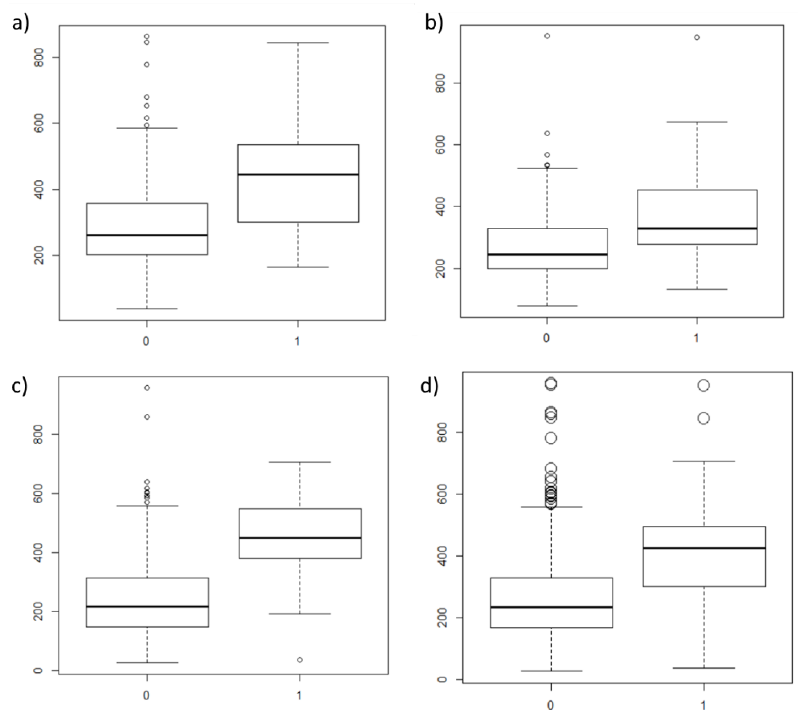
Figure 3. Mean burn severity (maximum dNBR) in non-destructive (0) and destructive (1) wildfires in ( a ) the Bay area ( b ) the North Sierra Foothills ( c ) Southern California, and ( d ) Statewide for all wildfires from 2000–2018. The boxplot depicts the minimum, maximum, and interquartile range (25th to 75th percentile), the median, and outliers displayed as circles.